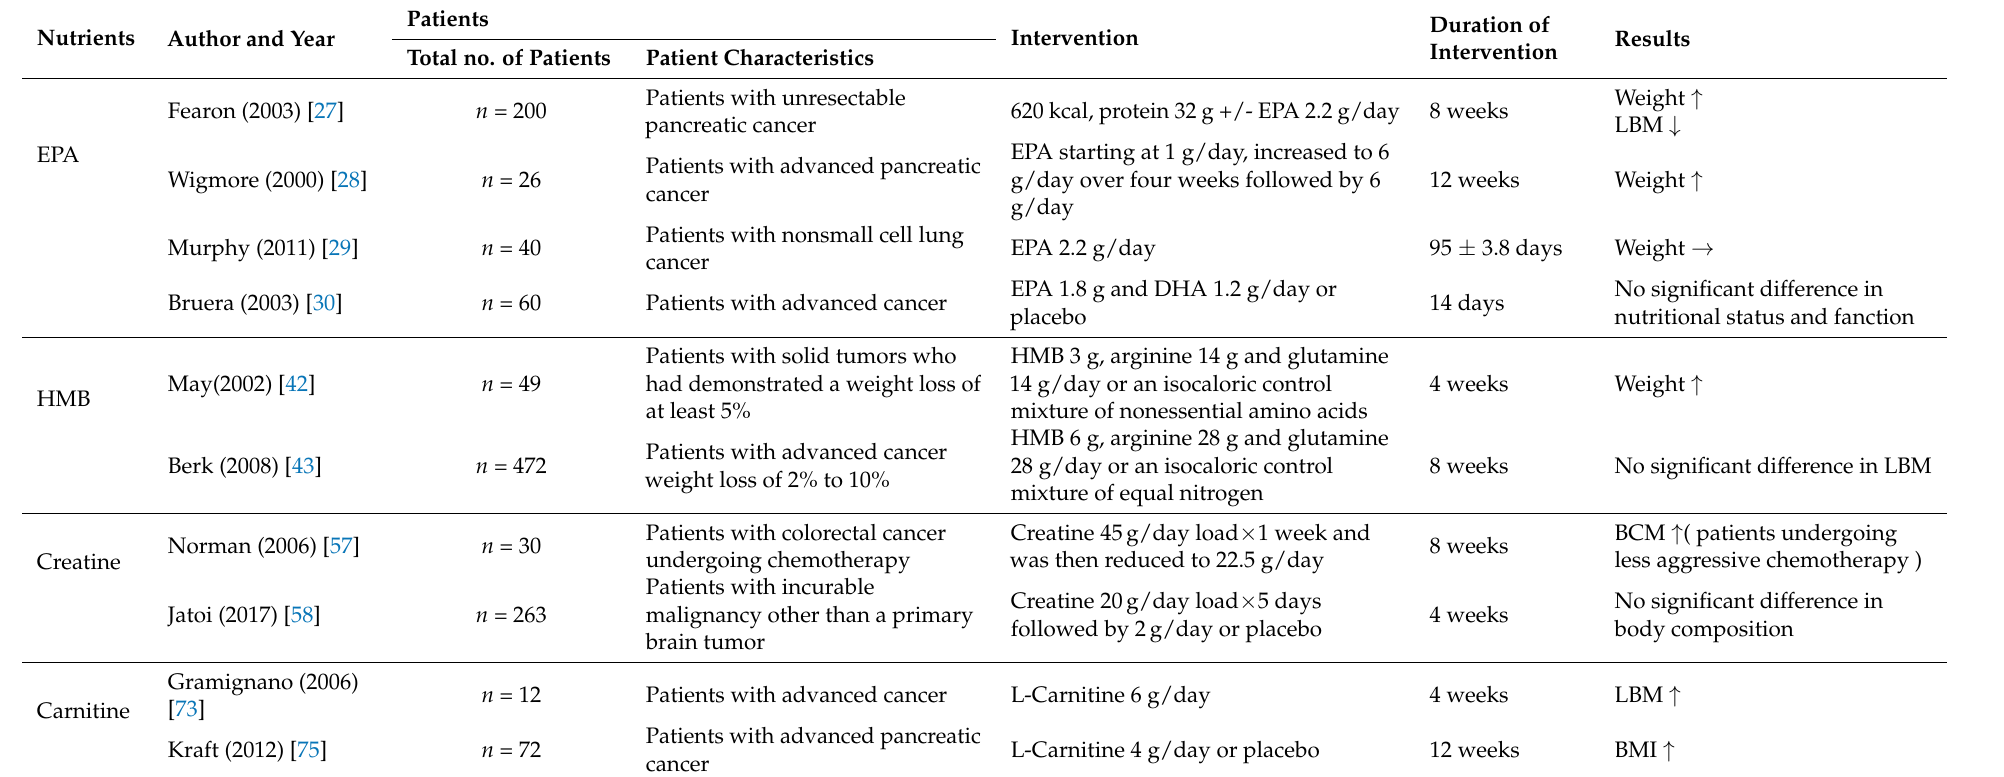
Table 1. Summary